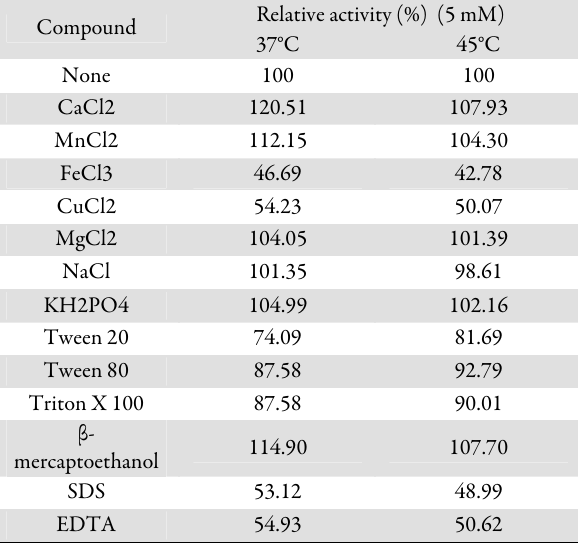
Tab. 3. Effect of metal ions, SDS, EDTA and β -mercaptoethanol on the activity of the amylase produced from Bacillus amyloliquefaciens and mean of three individual replicates were used for this